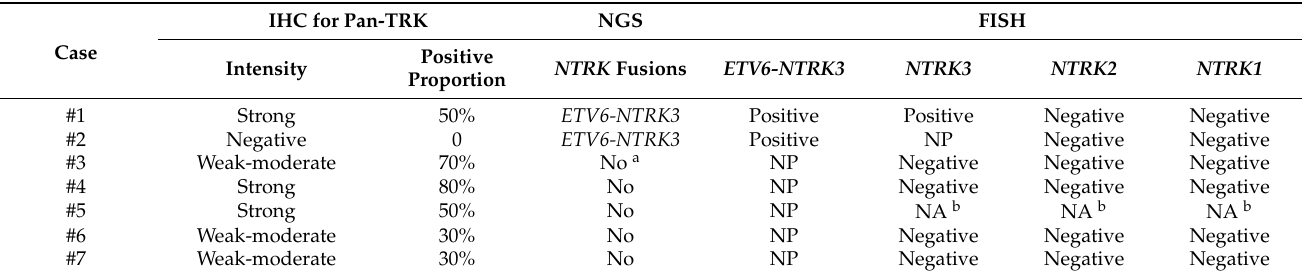
Table 1. FISH assessments in the cases with positive expression of Pan-TRK or NTRK fusion from NGS.